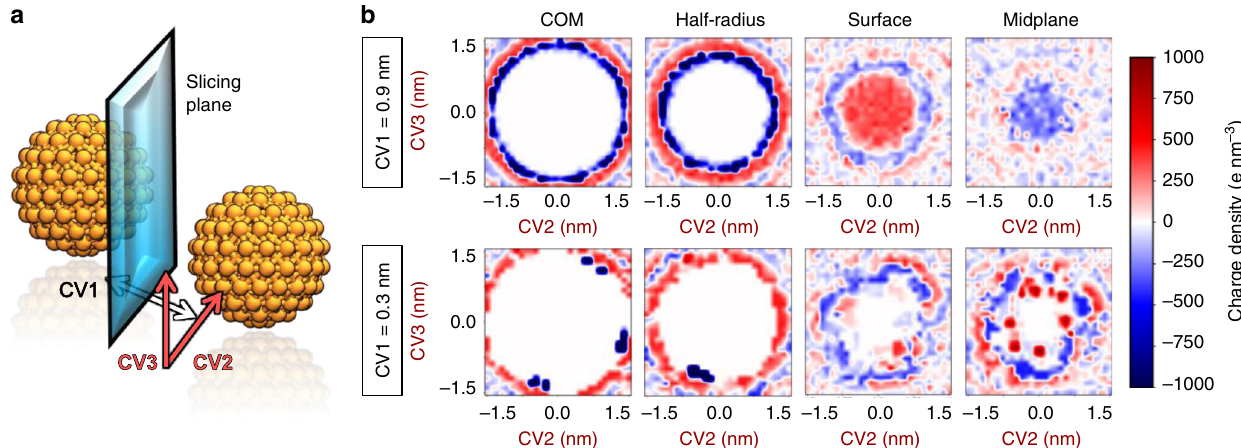
Fig. 4 Transversal charge density as a function of the distance between the NPs. a Graphical de fi nition of the collective variables of interest. CV1 is the minimum distance between the two NP surfaces. CV2 and CV3 are two bases perpendicular to CV1 chosen arbitrarily. The position of the slicing plane indicates the cuts on which the systems ’ charge density was estimated. b The charge density of the overall systems averaged over time for various slicing planes at CV1 = 0.9 nm (top) and CV1 = 0.3 nm (bottom). The four studied planes lie at (i) an NP ’ s center of mass (COM), (ii) half-way along the radius of an NP, (iii) at the van der Waals surface of an NP, and (iv) at the midplane between the two NPs. All plots are derived from systems with NPs loaded with